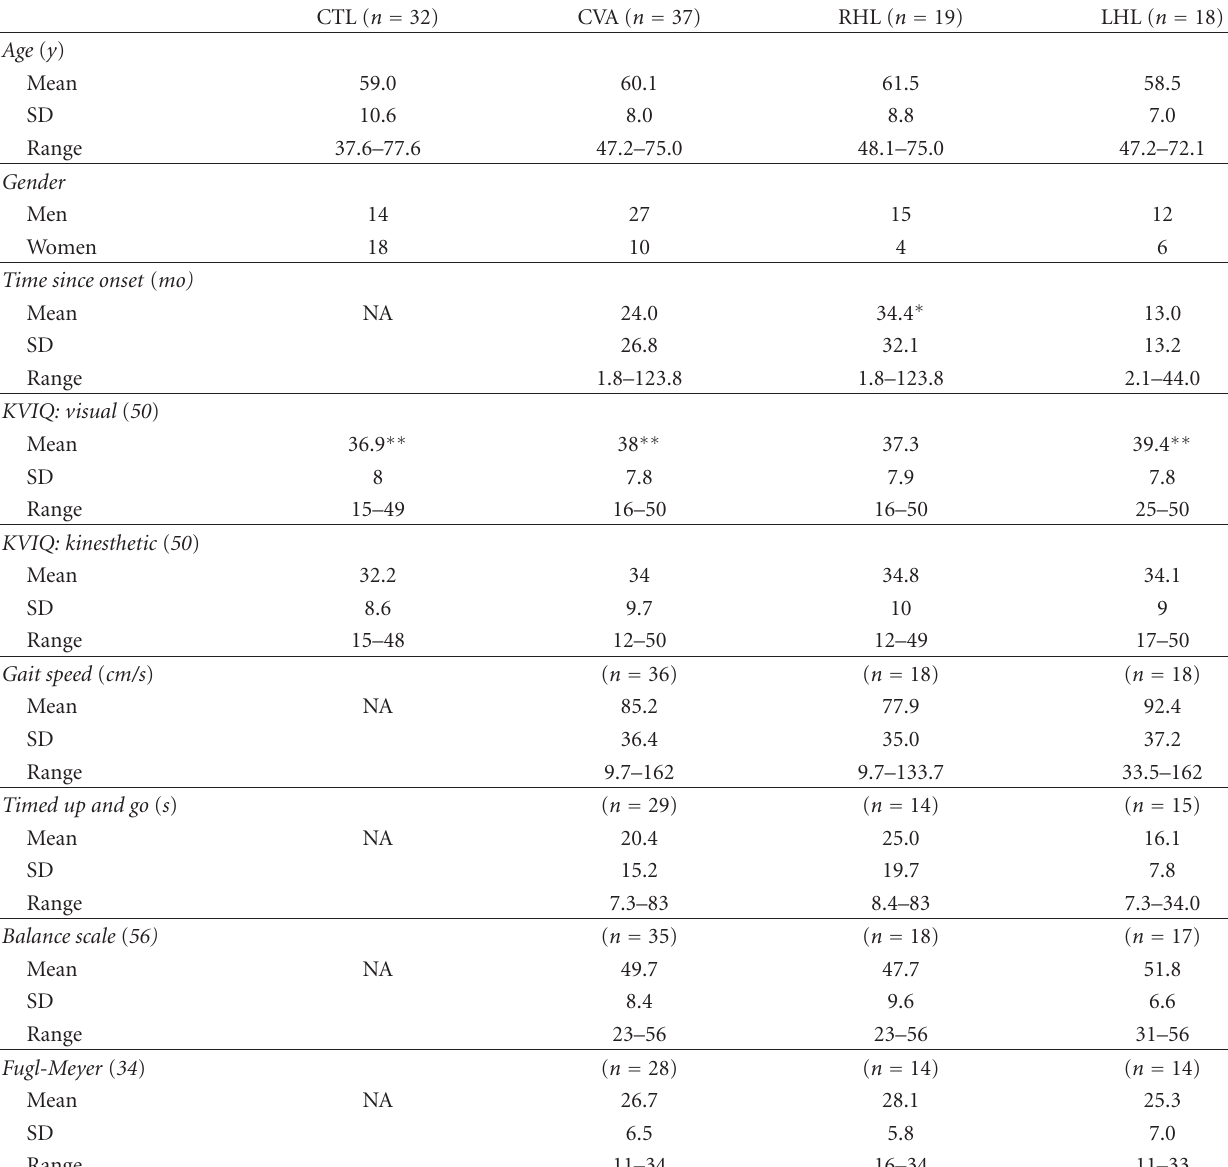
Table 1: Subject